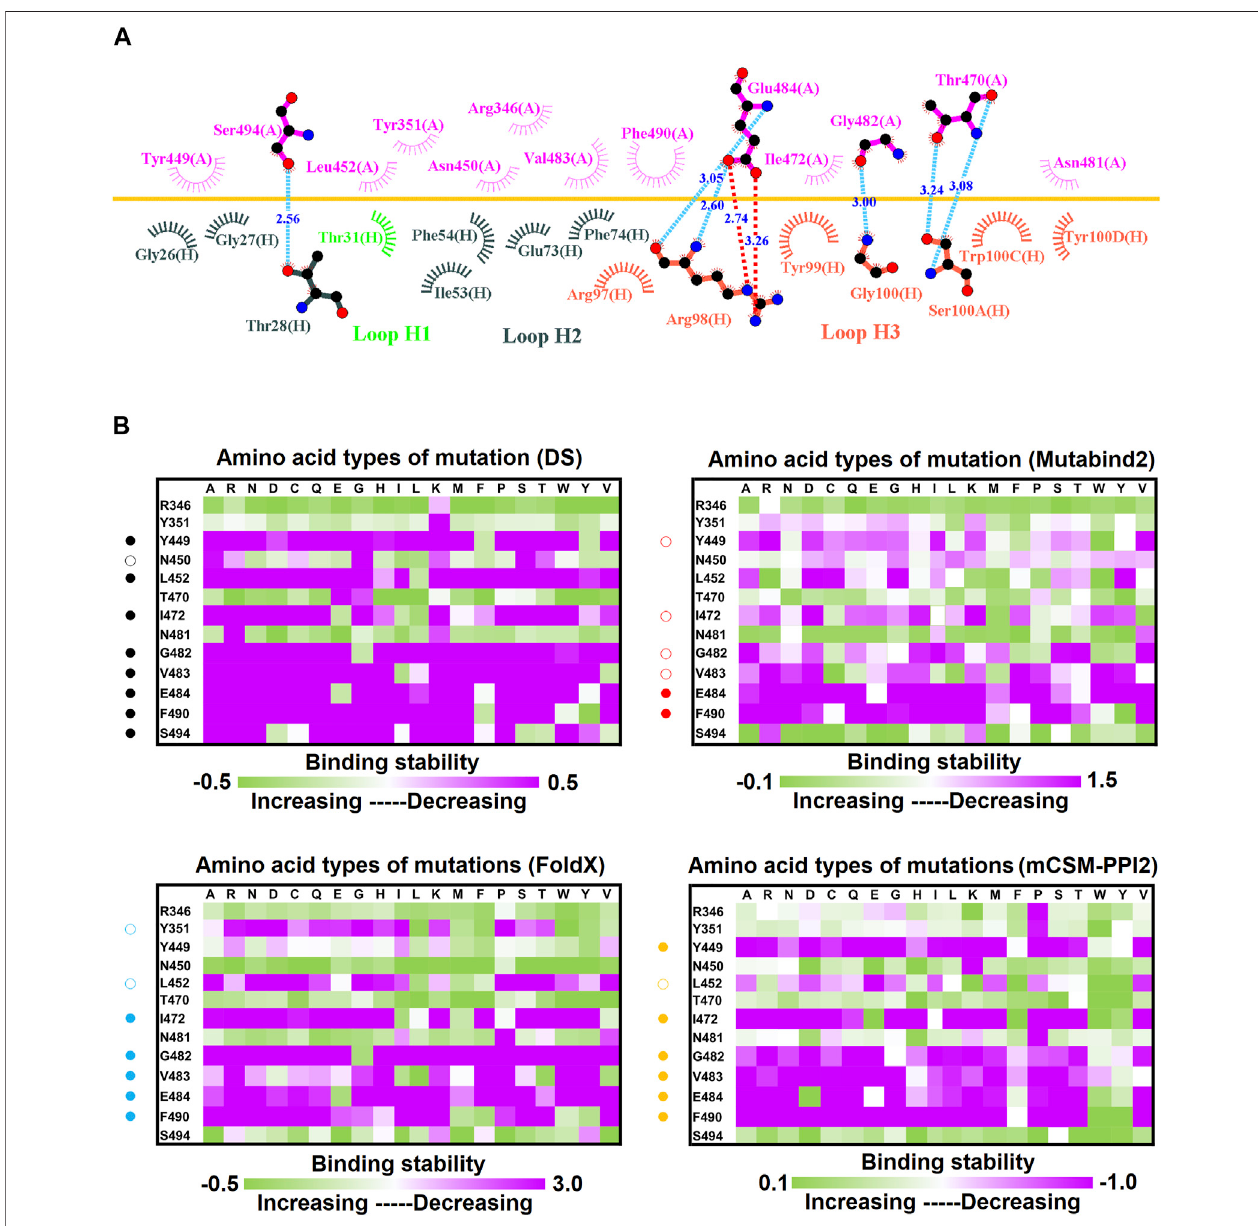
FIGURE 10 | Mutational heatmaps of the RBD targeting antibody 47D1. (A) LIGPLOT was employed to examine the interaction network of the SARS-CoV-2 RBD and 47D1. The RBD and light and heavy chains of 47D1 were labeled A, H, and L, respectively. The golden yellow line denotes the interface of the RBD – 47D1 complex. The interactive residues of the RBD are labeled and colored magenta. The hydrogen salt-bridges, bonds and hydrophobic interactions are represented by red, cyan dashes and arcs with spokes radiating toward the ligand atoms with which they are contact, respectively. (B) The mutational binding stabilities of RBD variants to 47D1 were estimated using FoldX, MutaBind2, DS 3.5, and mCSM-PPI2. The unit of binding stability was kcal/mole, and the obtained values were employed to create the heatmaps. Green (increased stability) and purple (reduced stability) were used to generate a color gradient and were applied in each box. In each heatmap, the moderately and signi fi cantly reduced stabilities were labeled with hollow and solid circles,